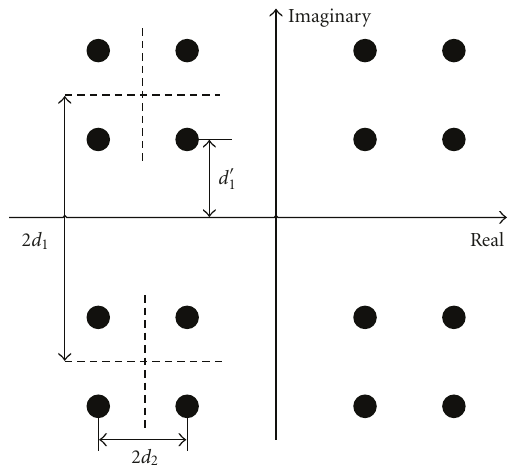
Figure 1: A 16-QAM constellation used in Hierarchical Modula-